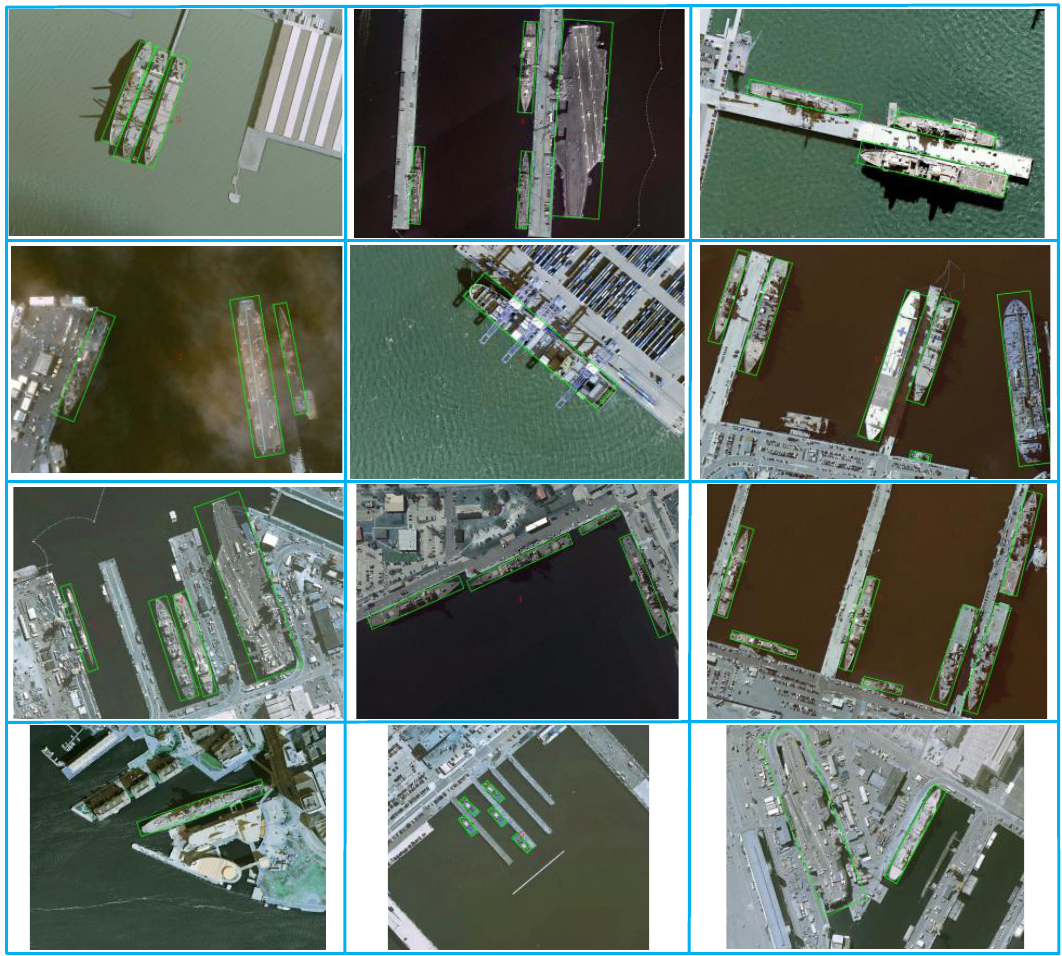
Figure 9. Visualization of detection results of proposed MFIAR-Net on test set of